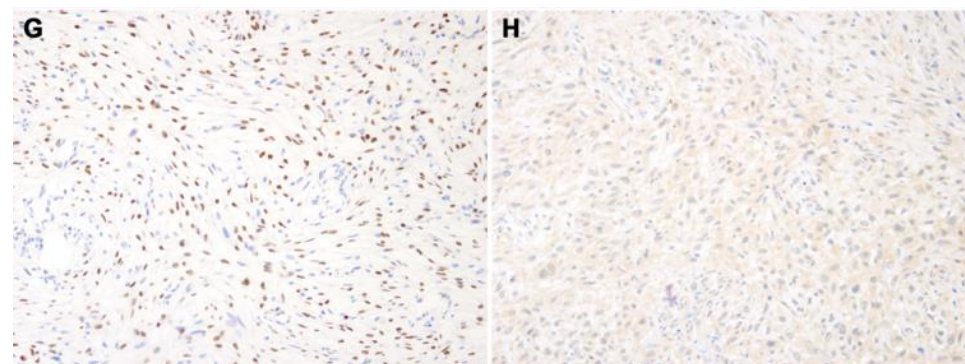
Figure 2. ( A ) Wide excision of proximal femur was performed. ( B ) Grossly, fibrous dysplasia portion is seen as a well-demarcated tan-gray mass with hard texture in the metaphysis of the femur (blue arrow). The osteosarcoma portion of the mass shows gray myxoid discoloration and fragile texture (red arrow). This portion was contiguous with cortical bone destruction and periosteal soft-tissue extension. ( C ) On low magnification, the tumors consist of an inner loosely cellular portion containing woven bone (right) and an outer highly cellular portion without woven bone (left). ( D ) The tumors destroyed the cortical bone and extended into the skeletal muscle. ( E ) On high magnification, the inner part of the tumor consists of curvilinear woven bone and fibrous stroma with bland spindle cells. ( F ) The outer part of the tumor shows highly cellular proliferation of pleomorphic cells with irregularly shaped hyperchromatic nuclei. Malignant osteoid interlaced the tumor cells. ( G ) SATB2 immunostaining demonstrates diffuse nuclear positivity. ( H ) CDK4 immunostaining shows negative result, suggesting a lack of MDM2 and/or CDK4